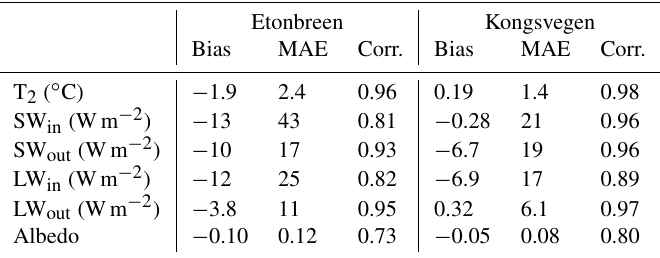
Table 3. Bias, mean absolute error (MAE), and correlation (corr.) between simulated and observed daily mean temperature, radiation, and albedo at Etonbreen and